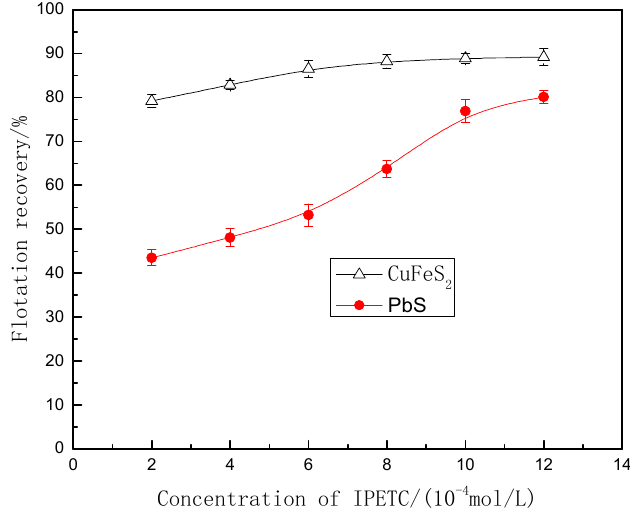
Figure 3. Recoveries of chalcopyrite and galena as a function of dosage (pH = 9.5).